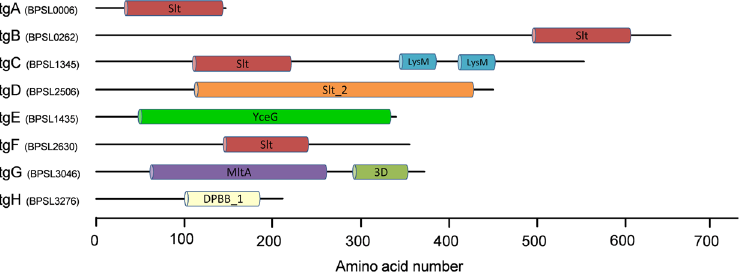
Figure 1. Schematic representation of predicted Ltgs in B . pseudomallei K96243. Key domains are highlighted and were identified using Pfam database and Interpro. Slt; Pfam PF01464, LysM; Pfam PF01476, Slt_2; Pfam PF13406, MltA; Pfam PF03562, 3D; Pfam PF06725, DPBB_1; Pfam PF03330, YceG; Pfam